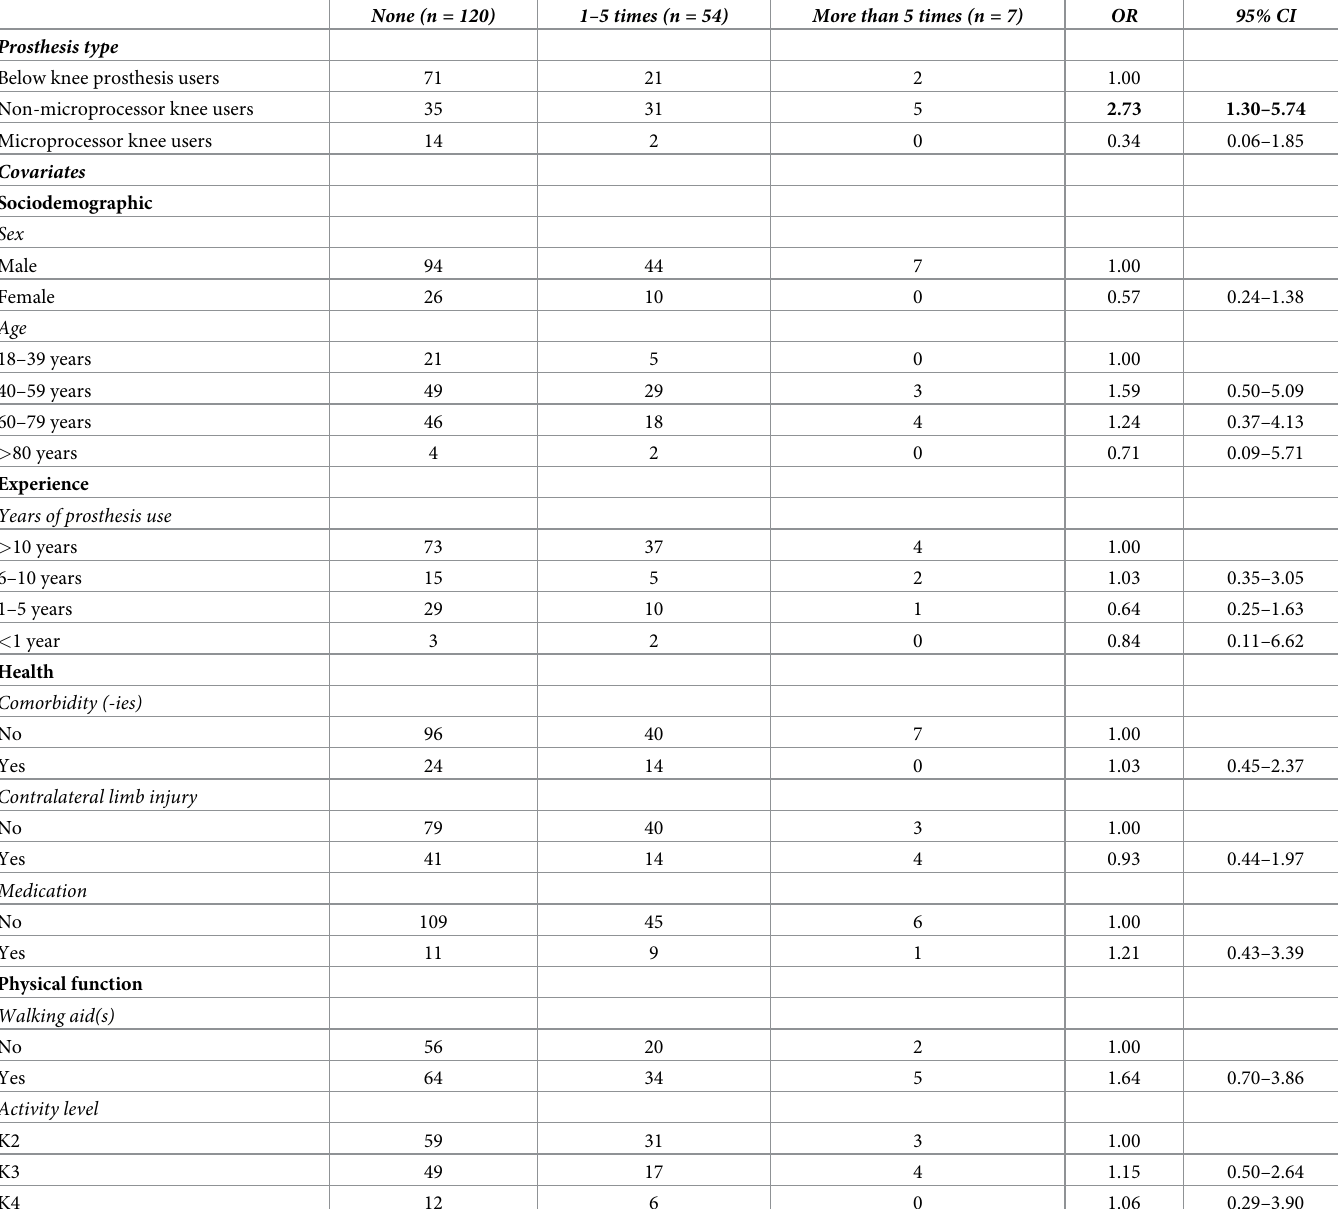
Table 3. The frequency of falls among those that reported at least one trip/stumble in the previous 4 weeks, ordered by prosthesis type and each of the covariates. Odds ratios (OR) and 95% Confidence Intervals (CI) are shown; bold text indicates statistically significant